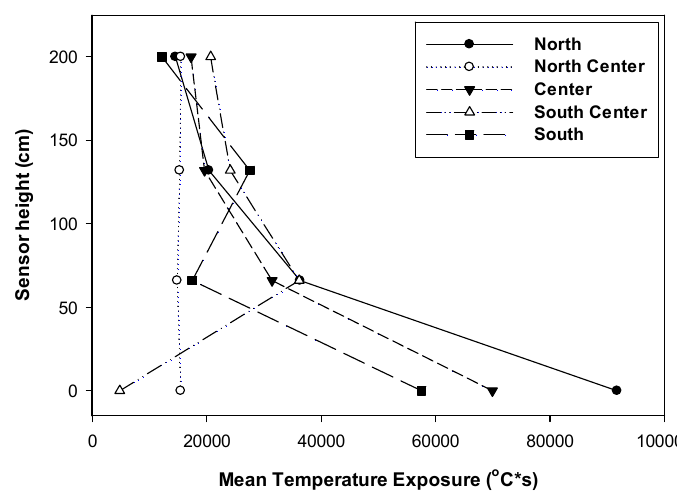
Figure 4. Gap position and vertical distribution of mean temperature exposure (MTE) at different positions in the group selection harvest in slash pine .